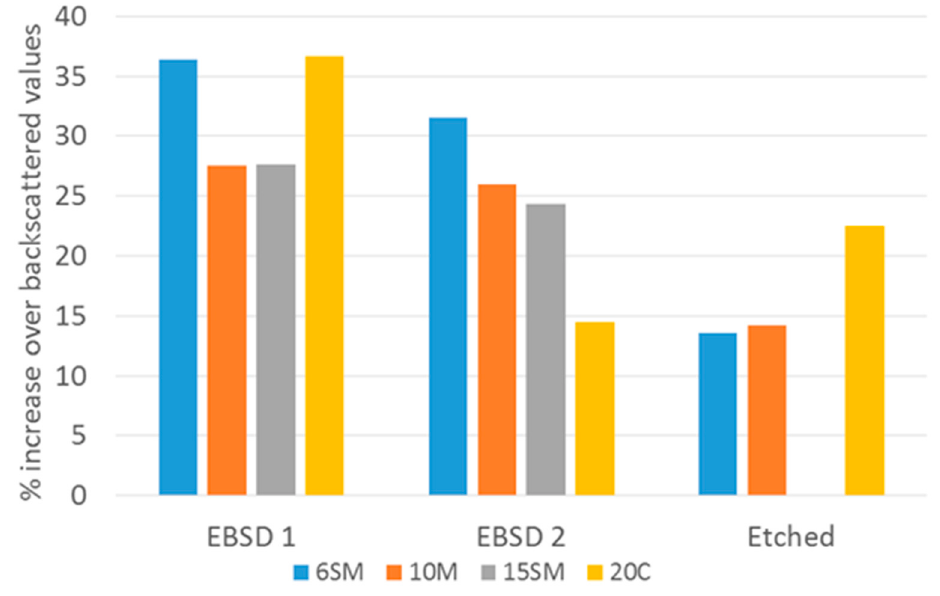
Figure 7. Percentage difference in contiguity from reference backscattered image average for the three other image types plotted for each grade.